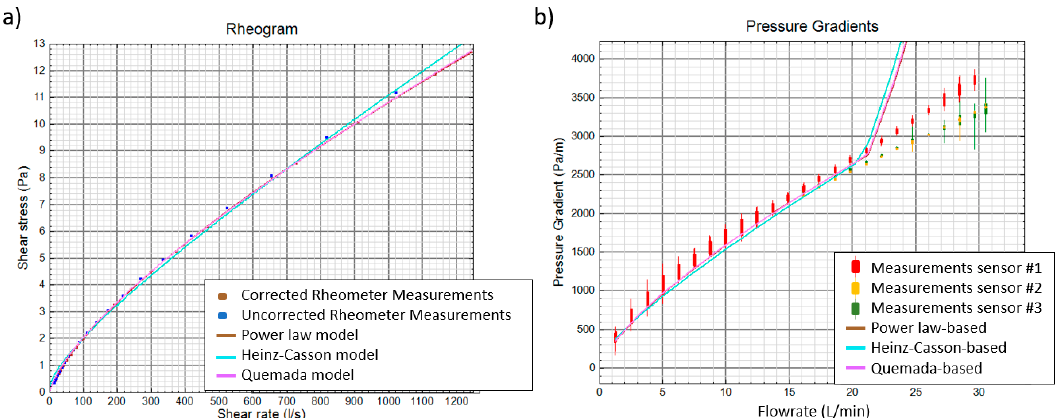
Figure 11. ( a ) Rheogram of an aqueous solution of polyanionic cellulose (PAC) (0.2%) measured at 25 °C with a scientific rheometer, ( b ) comparison between measured pressure gradients with the three differential pressure sensors and pressure gradients calculated with power law, Quemada and Heinz-Casson rheological behaviors.